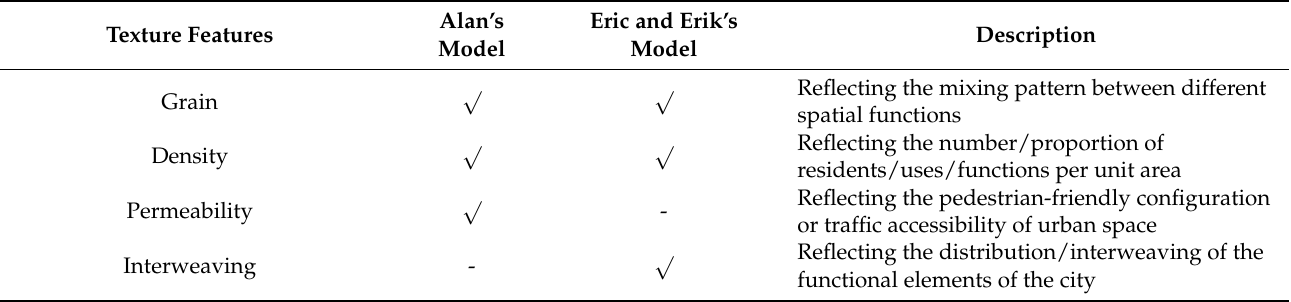
Table 2. Comparison of spatial texture characteristics of LUM conceptual